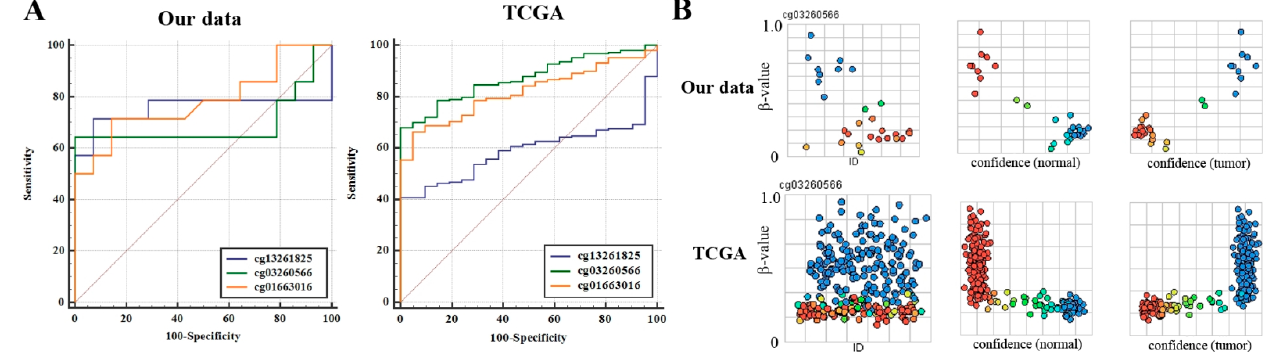
Figure 3. Evaluation of prediction performance of a model in our data and TCGA lung cancer data. ( A ) Prediction performance of a logistic regression model based on three CpGs was evaluated in our data (left) and TCGA (right) test dataset. ROC curves were plotted using the MedCalc software. ( B ) Prediction certainty of a logistic regression model based on cg03260566 was estimated in a test dataset. Y-axis indicates β -value. “ID” in the left panel represents identification number of test samples. In the middle and right panels, the X-axis indicates confidence (normal or tumor) that predicts samples as normal (middle panel) or tumor (right panel) for each β -value on the Y-axis. The sky blue and red orange circles indicate high and low confidence, respectively.